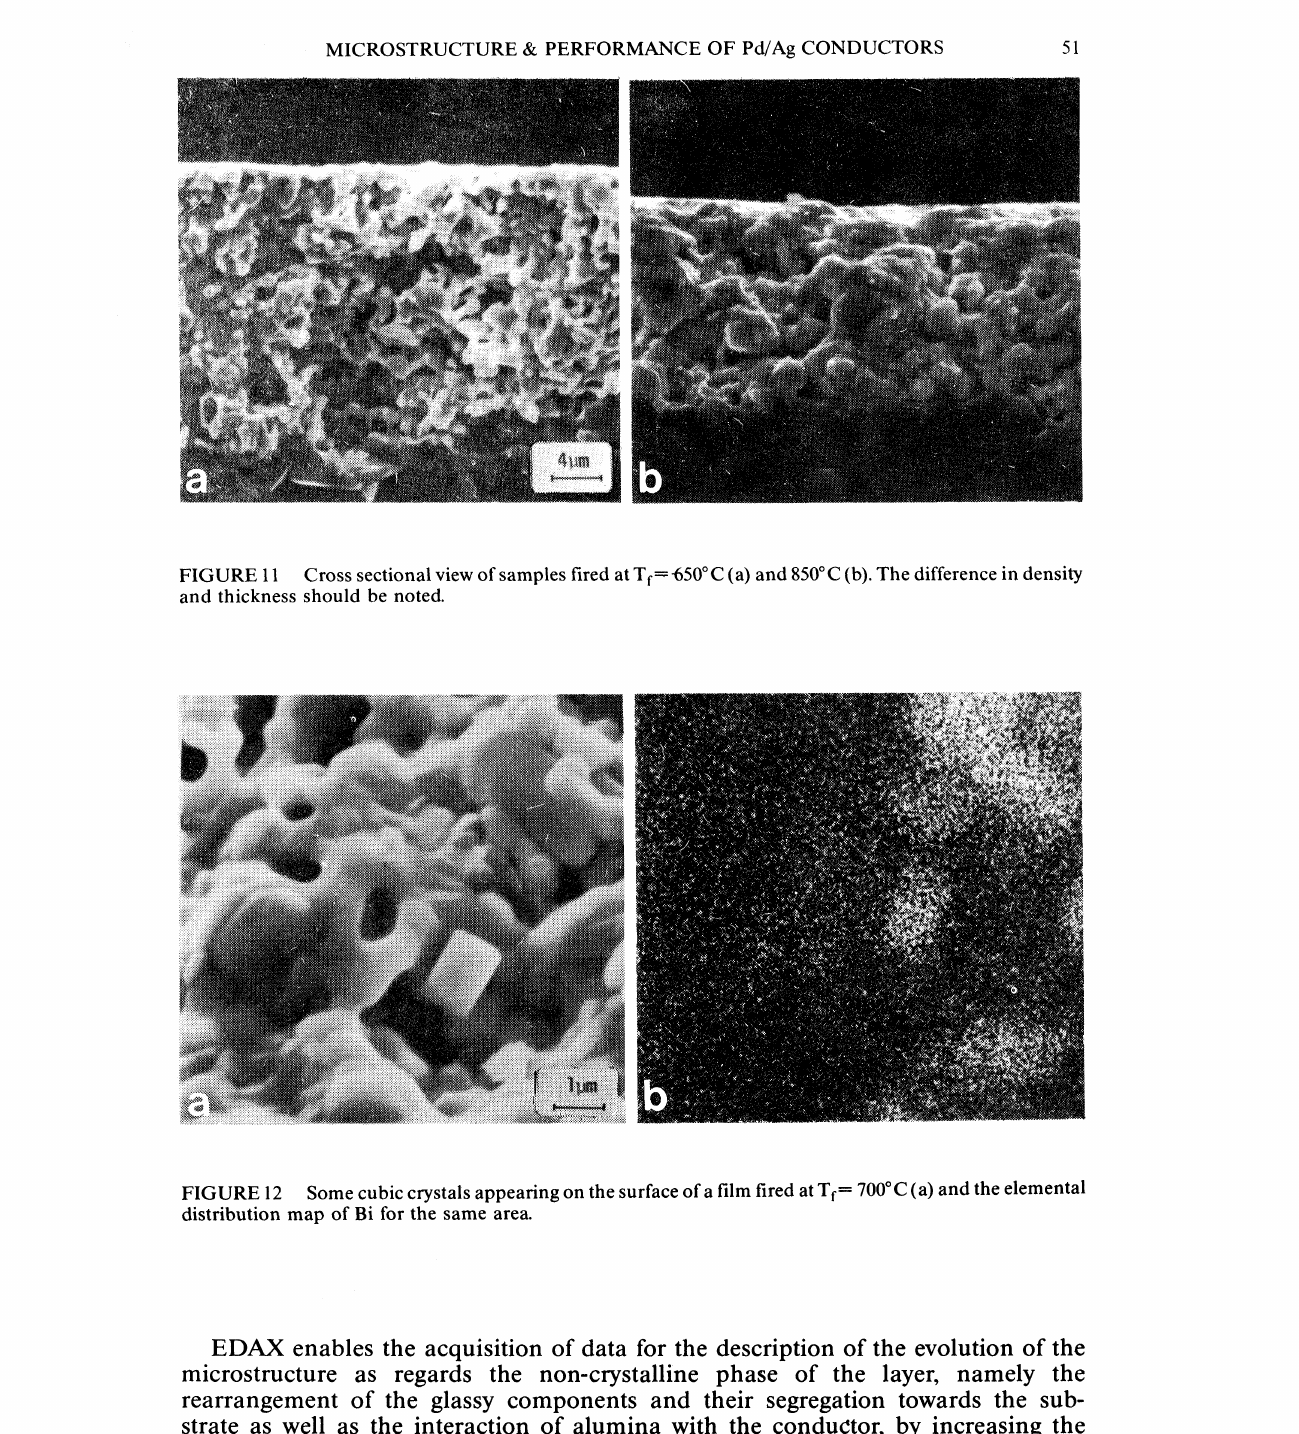
EDAX enables the acquisition of data for the description of the evolution of the microstructure as regards the non-crystalline phase of the layer, namely the rearrangement of the glassy components and their segregation towards the sub- strate as well as the interaction of alumina with the conductor, by increasing the firing